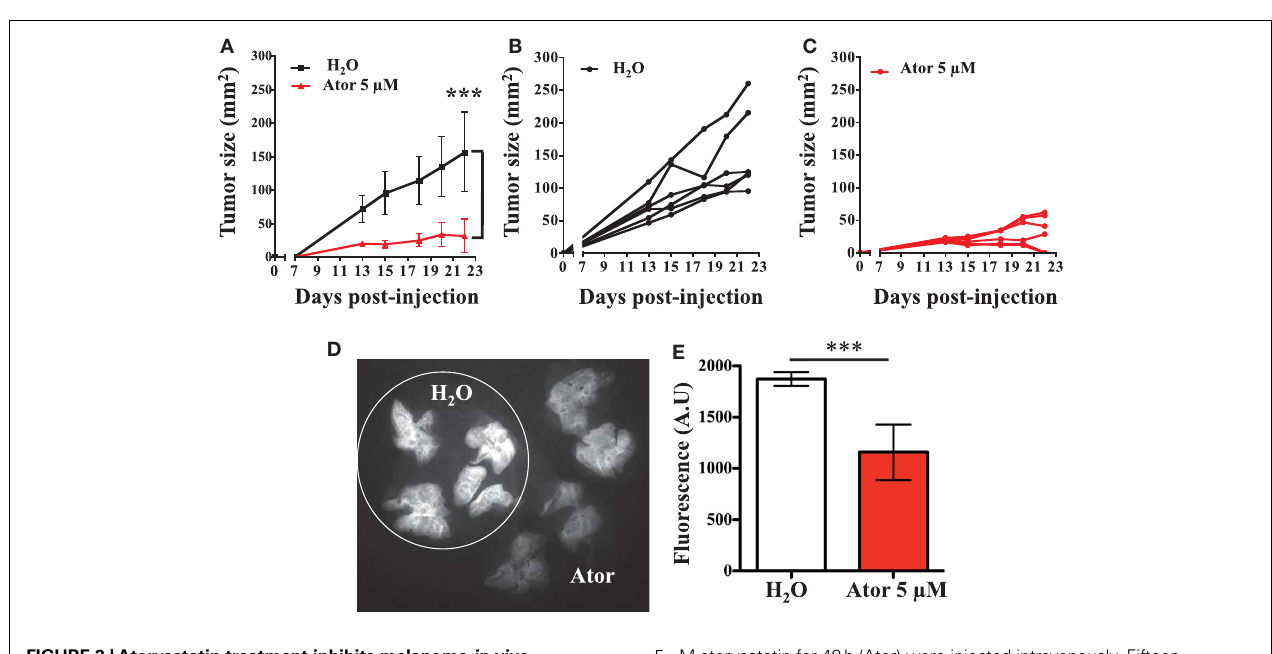
FIGURE 2 |Atorvastatin treatment inhibits melanoma in vivo development and metastasis. LB1319-MEL cells untreated (H 2 O) or pretreated with atorvastatin 5 µ M for 48h (Ator) were injected subcutaneously into the flank of six nude mice.Tumor growth was measured every 2–3days (A) . *** P < 0.001; versus control condition using the two-way ANOVA test.Tumor growths for each mice are represented (B,C) . LB1319-MEL cells untreated (H 2 O) or pretreated with